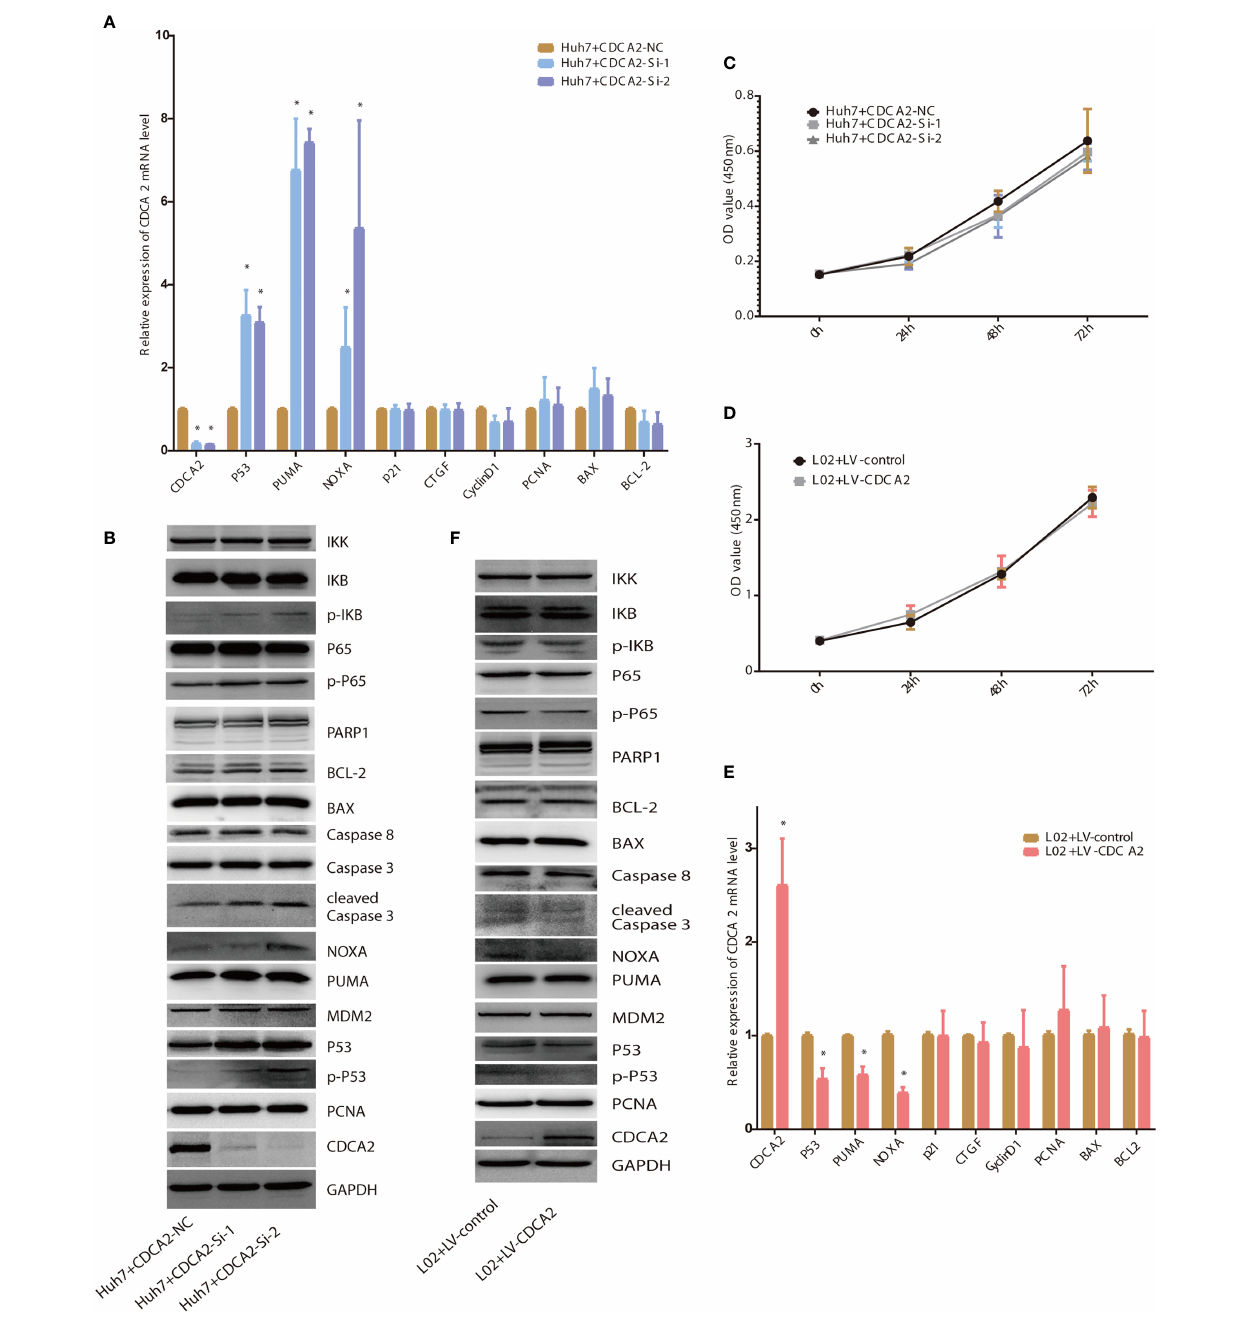
FIGURE 8 | Cell division cycle associated 2 (CDCA2) foundations via p53. (A, B) . The mRNA and protein levels of the proliferation- and apoptosis-related genes in Huh7 treated with CDCA2 Si-1/2. (C, D) The proliferation of CDCA2 Si-1/2-treated Huh7 cells and LV-CDCA2-treated L02 cells at different time points detected by Cell Counting Kit-8 (CCK8) assay. (E, F) The mRNA and protein levels of the proliferation- and apoptosis-related genes in L02 treated with LV-CDCA2. *p <